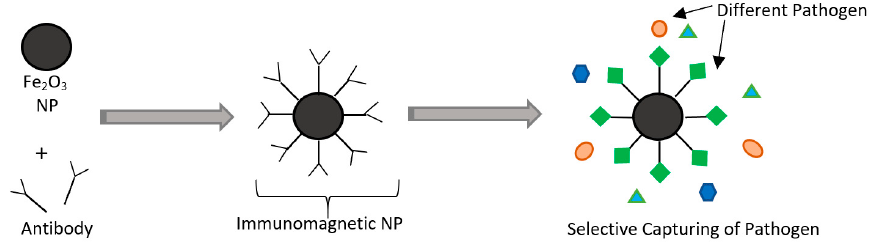
Figure 12. Schematic of immunomagnetic separation (IMS) with the use of nanoparticles (NPs) and antibodies.